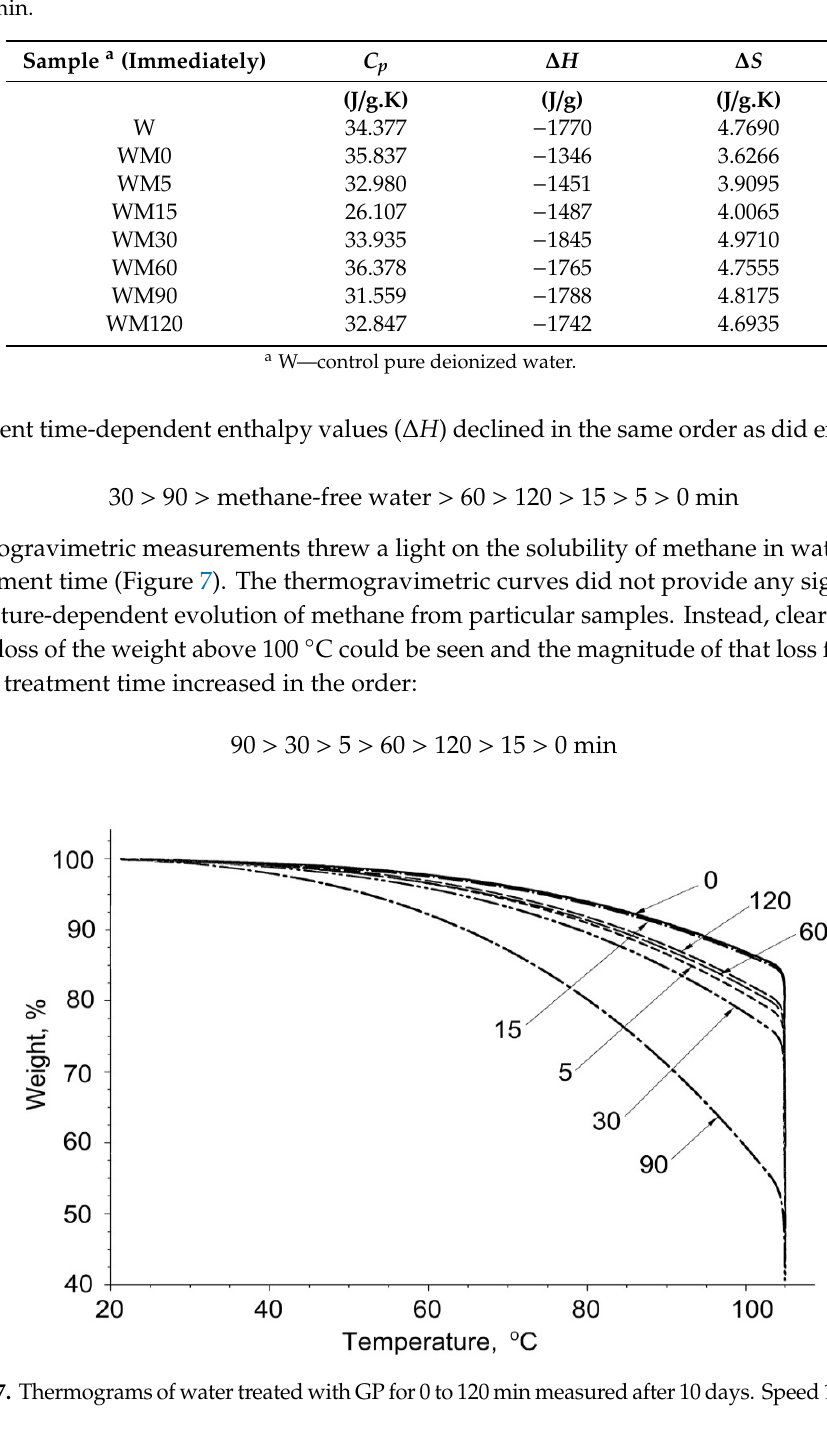
Table 3. Thermodynamic data for deionized water saturated with methane (WM) treated with GP for 0 to 120 min.